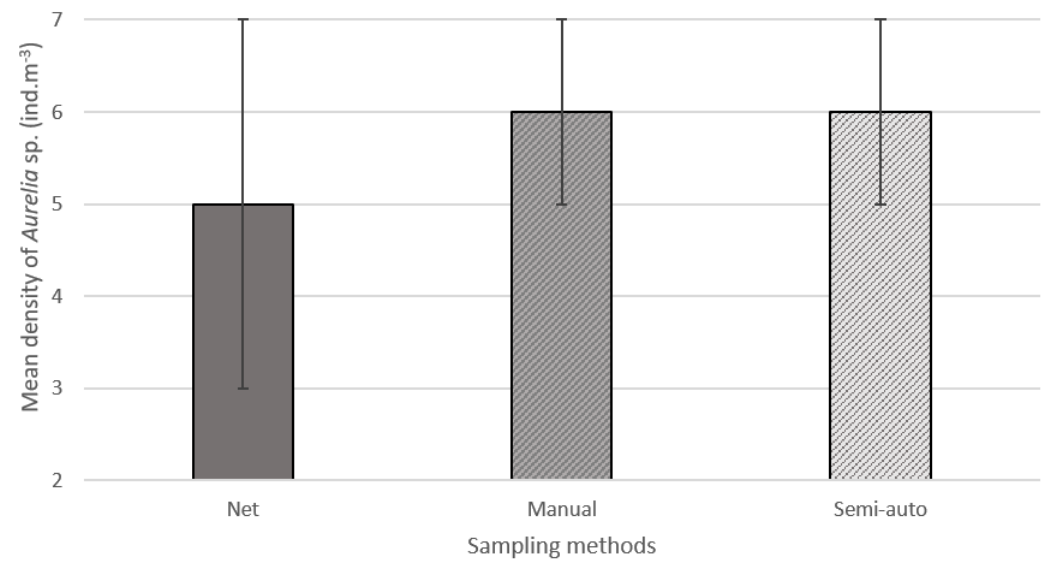
Table 1. Numbers of Aurelia sp. counted on drone pictures for the three sampling stations, including the manual counts with ImageJ (“Manual”) and the mean (95% CI, n = 100 iterations) from the counts with the R Studio detection program (“Semi - auto”).